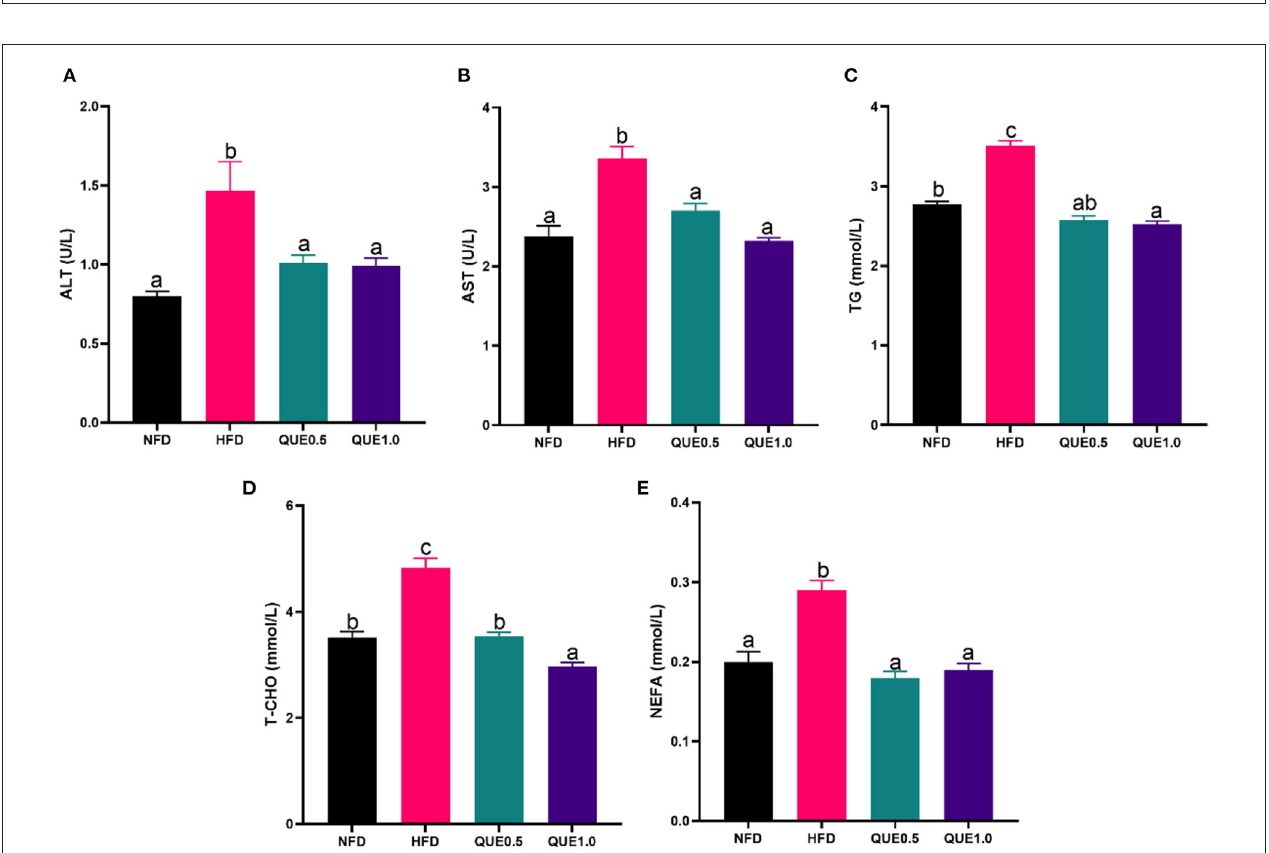
FIGURE 2 | Blood biochemistry of fish fed with experimental diets. (A) ALT activity; (B) AST activity. (C) TG content. (D) T-CHO content. (E) NEFA content. AST, aspartate aminotransferase; ALT, alanine aminotransferase; TG, triacylglycerols; T-CHO, total cholesterol; NEFA, non-esterified-free fatty acids. Different letters indicate a significant difference among groups ( P <